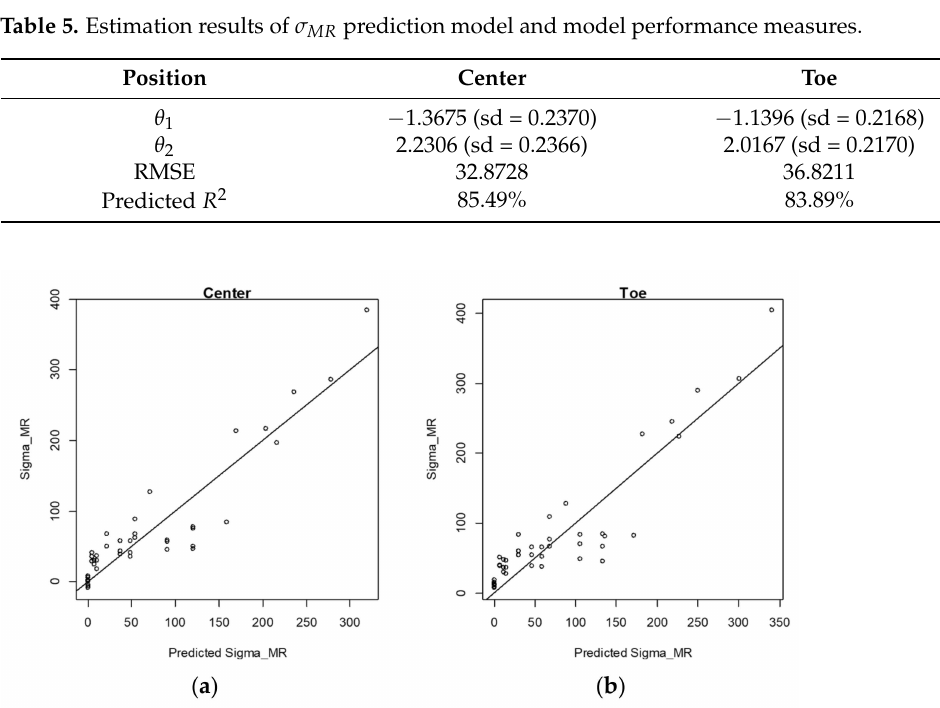
Figure 17. Comparison between the predicted value of the mean residual stress σ MR and that calculated by thermal elastic–plastic analysis: ( a ) The predicted ( X -axis) and calculated ( Y -axis) σ MR for the welding center and ( b ) the predicted ( X -axis) and calculated ( Y -axis) σ MR for the welding toe. The prediction model for the welding residual stress ( σ TR ) is given in Equation